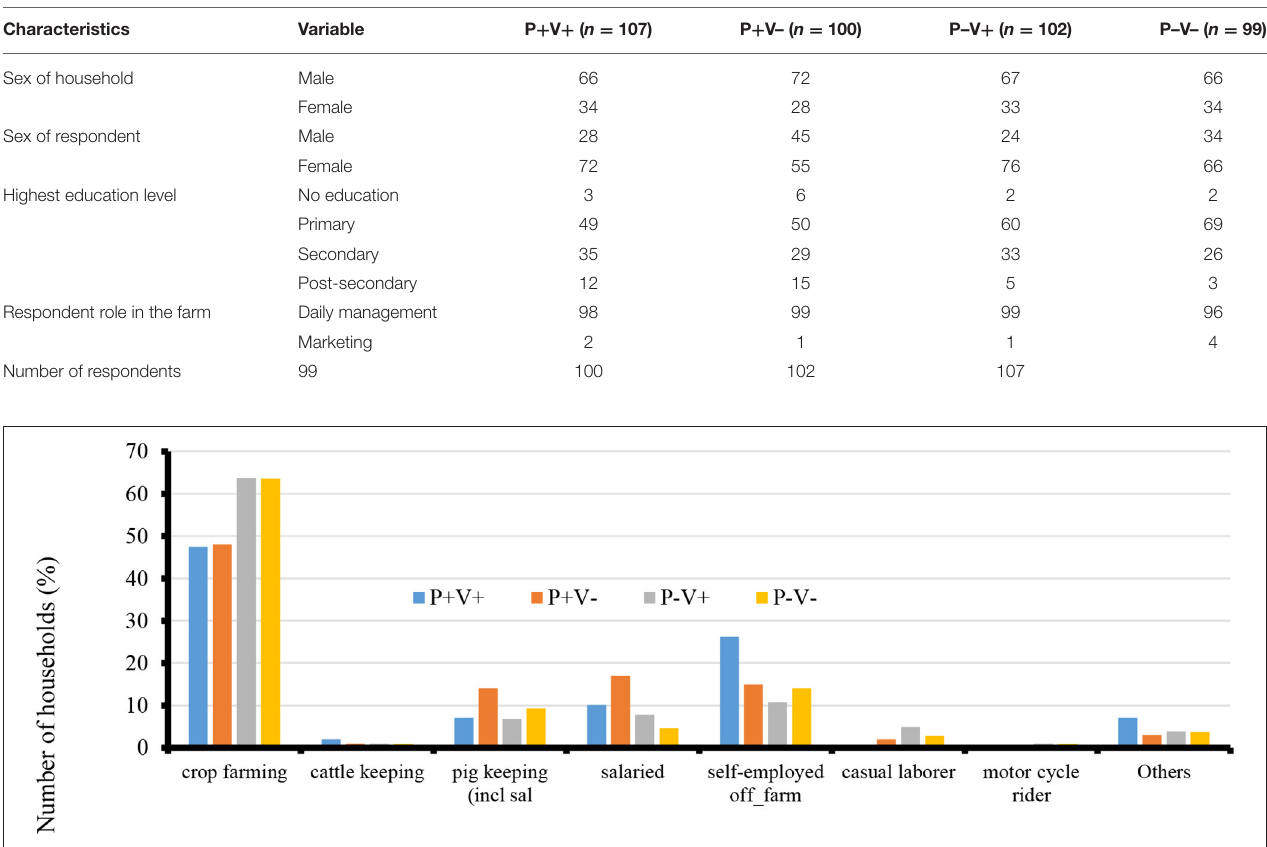
TABLE 2 | Household demographic characteristics (%). Characteristics